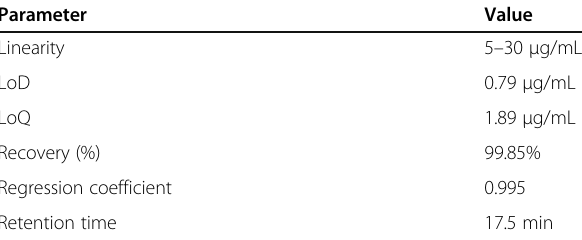
Table 4 GC validation report for the determination of squalene Parameter